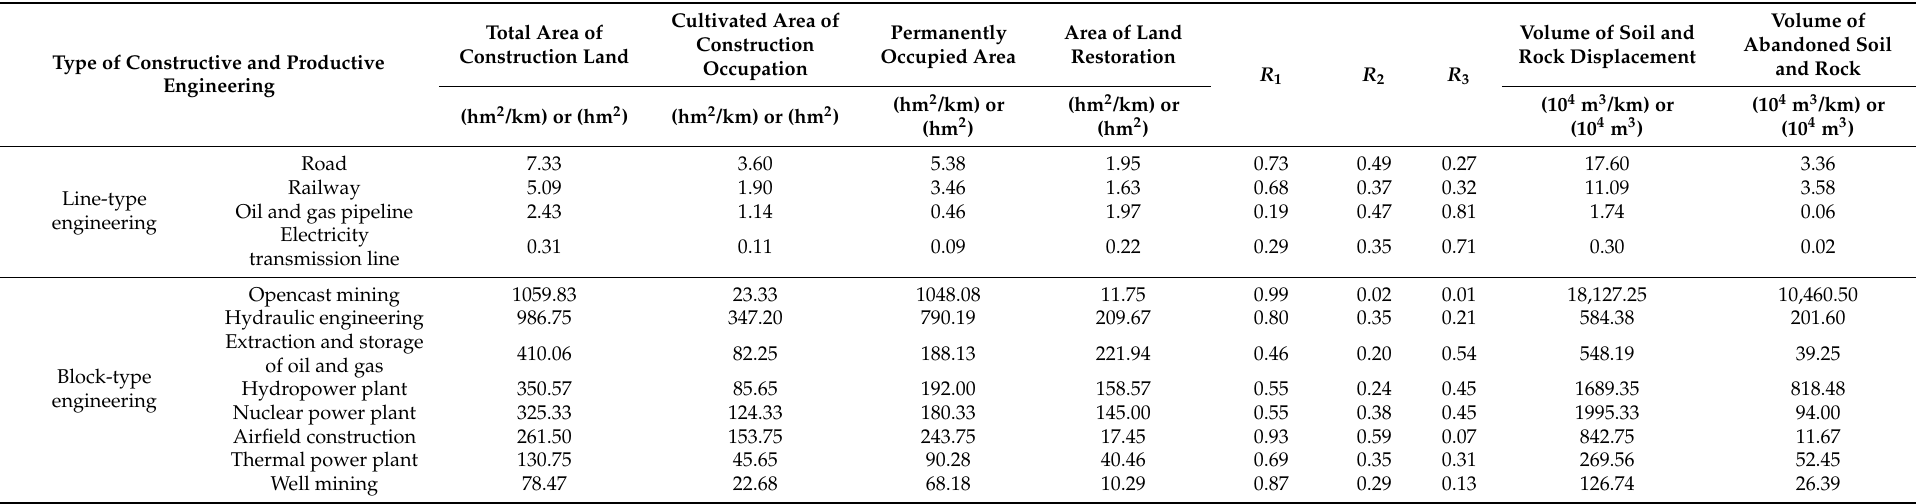
Table 1. Comparison of the surface impacts of line-type engineering (per km) and block-type engineering (per single item).